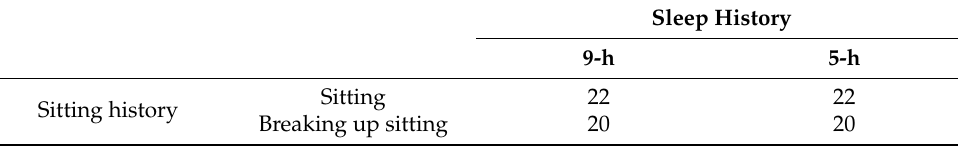
Table 1. Number of participants in each experimental condition